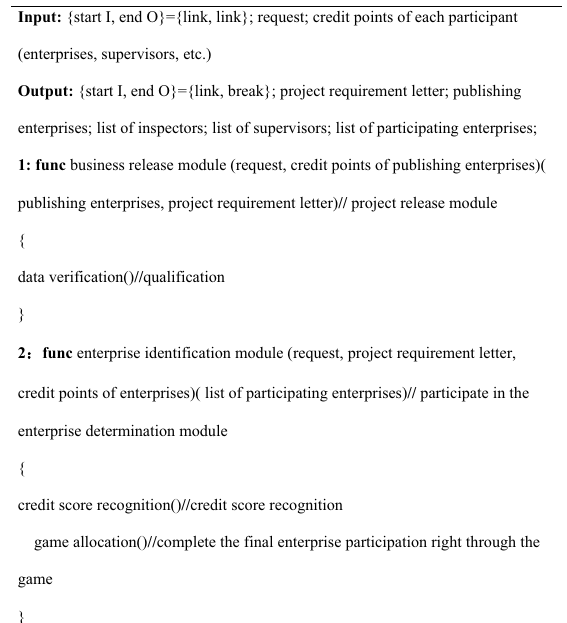
Algorithm 1: Initialize Smart Contract